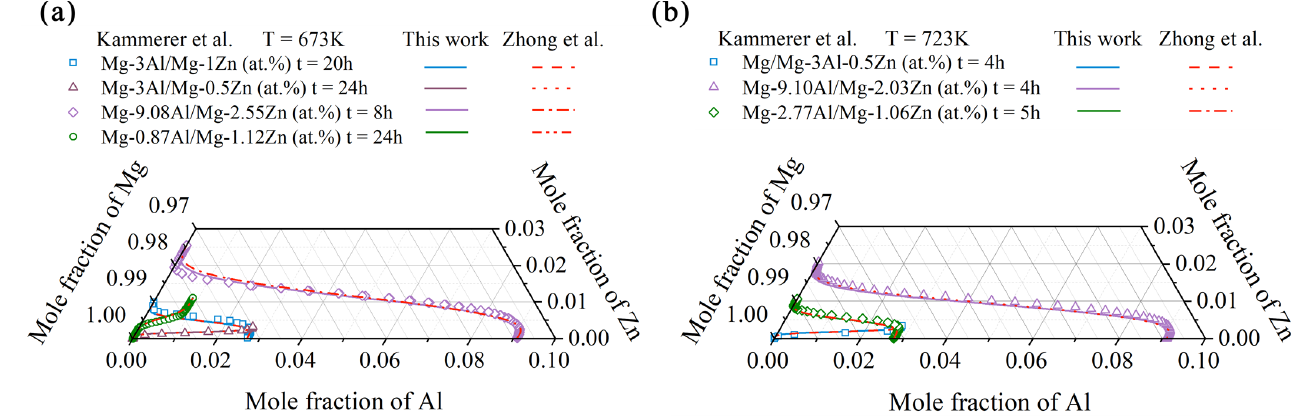
Figure 3. Model-predicted diffusion paths in the hcp Mg–Al–Zn system at ( a ) 673 and ( b ) 723 K due to the present atomic mobilities (solid lines) compared with those of Zhong et al. [32] (dashed lines) and the experimental data [35] (in symbols).